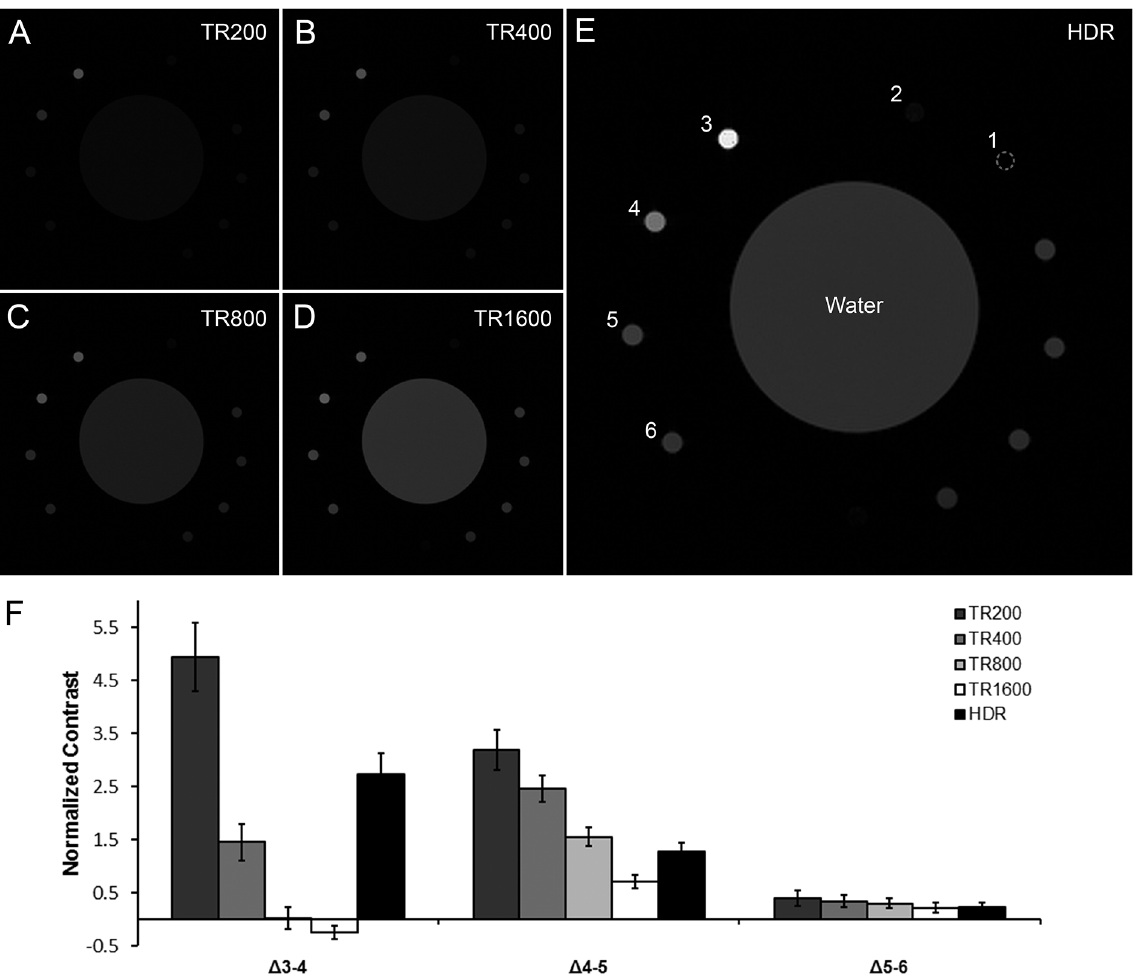
Figure 4. T 1 -weighted HDR-MRI. A series of images were acquired with constant T E at 10.635 ms and varying T R at (A) 200 ms (B) 400 ms (C) 800 ms and (D) 1600 ms. Images A–D were computationally merged by the HDR algorithm to generate the (E) HDR-MR image. The HDR image accentuated the contrast between samples 3 and 4 without suppressing samples 5 and 6 into the background. None of the LDR images, A–D, captured both features simultaneously. While image A had the largest normalized contrast, it also had the poorest SNR. Conversely, images with better SNR had worse normalized contrast, most notably between samples 3 and 4. HDR-MRI combined the complementary features of each image. (F) Quantification of contrast normalized against water. Error bars represent standard